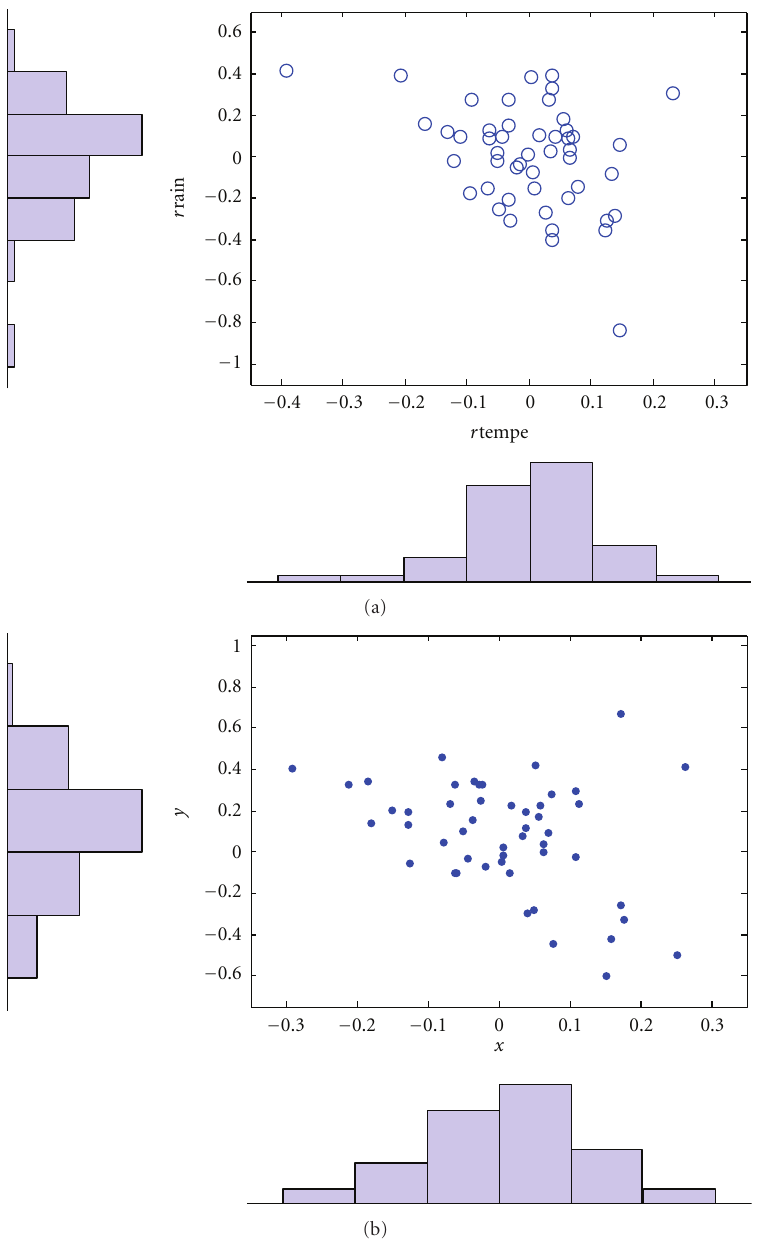
Figure 8: Scatter plots of real residuals (a) and student-based copula simulated residuals